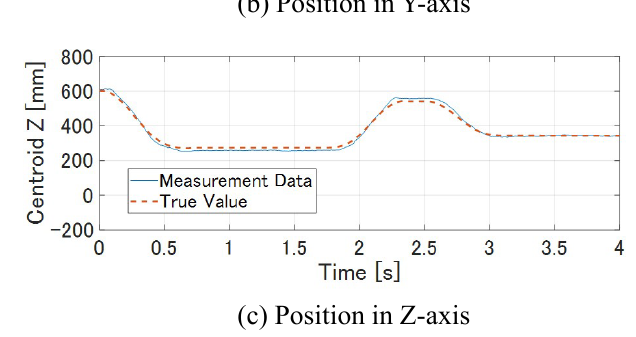
Figure 18. Centroid of cube.